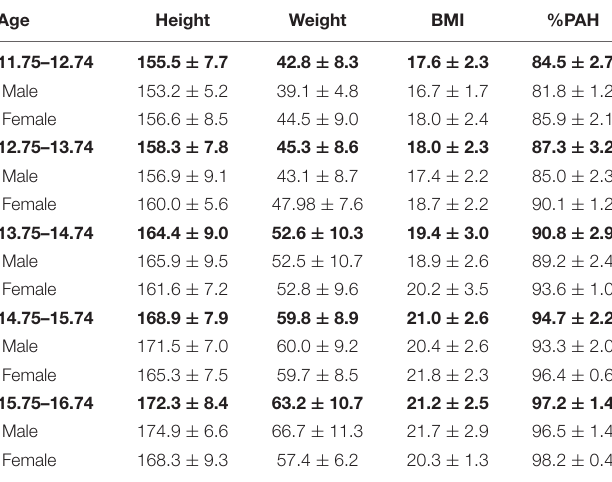
TABLE 2 | Descriptive information about height, weight, BMI and %PAH with means and standard deviation (M ± SD) per sex and age